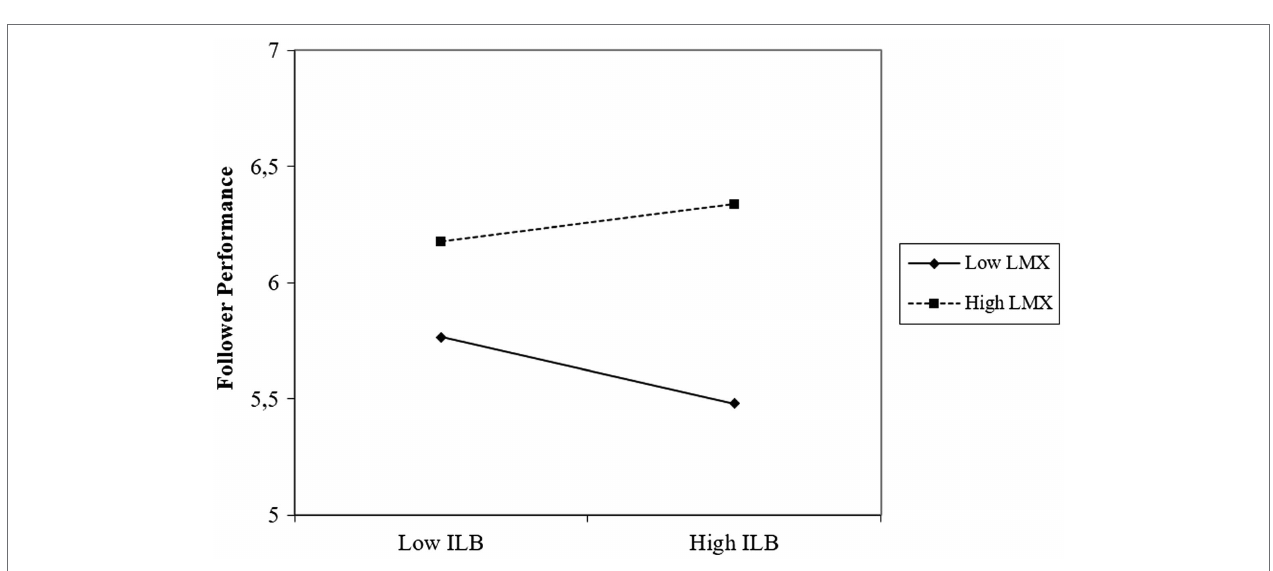
FIGURE 2 | Effect of leader narcissism and leader gender on follower perceptions of inconsistent leader